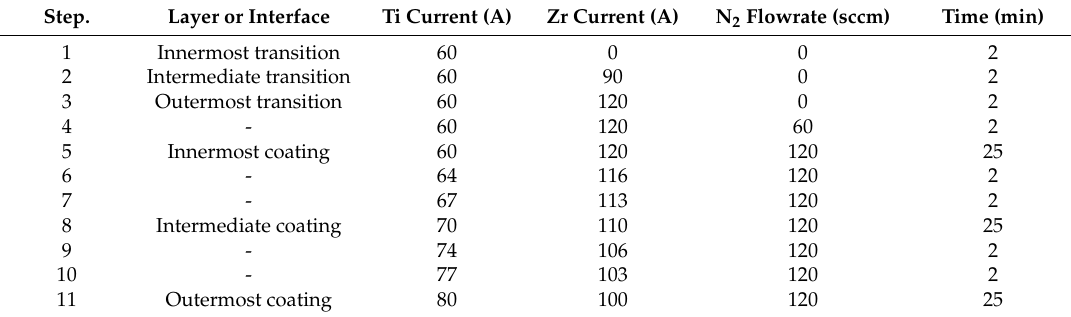
Table 1. Preparation process and parameters of ZrTiN gradient